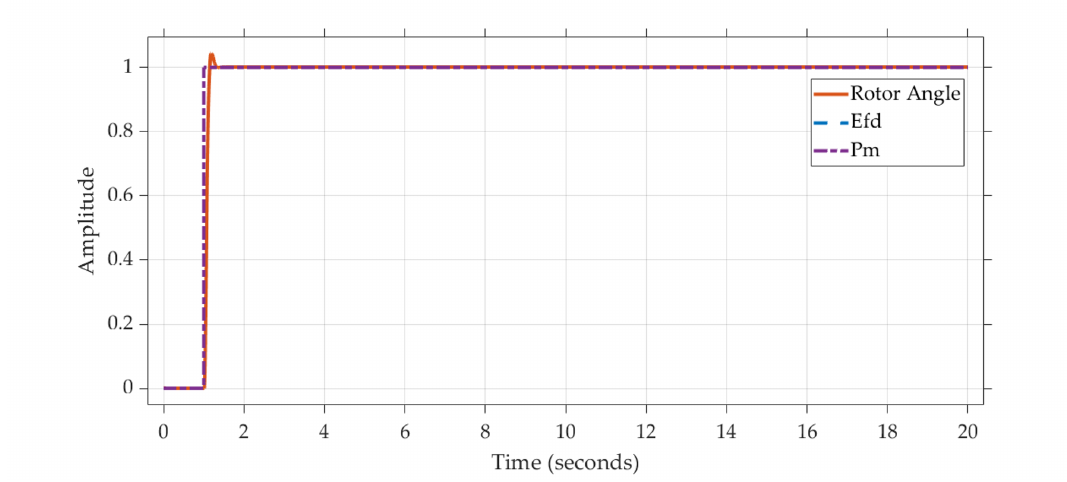
Figure 4. Rotor angle when E FD = 1, P m = 1, and learning rate = 10. Case Study 2. Setpoints change—E FD = 2.395 with no initial conditions.